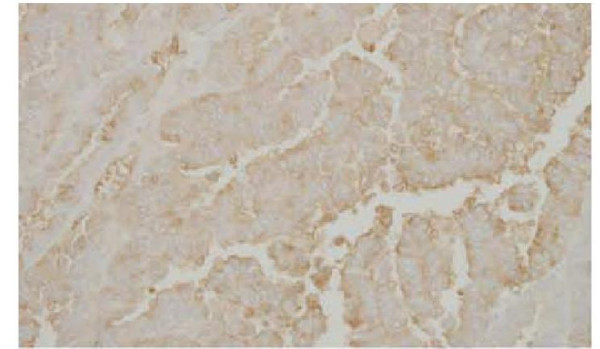
Tumor showed positive staining for Ulex Europaeus agglutinin.